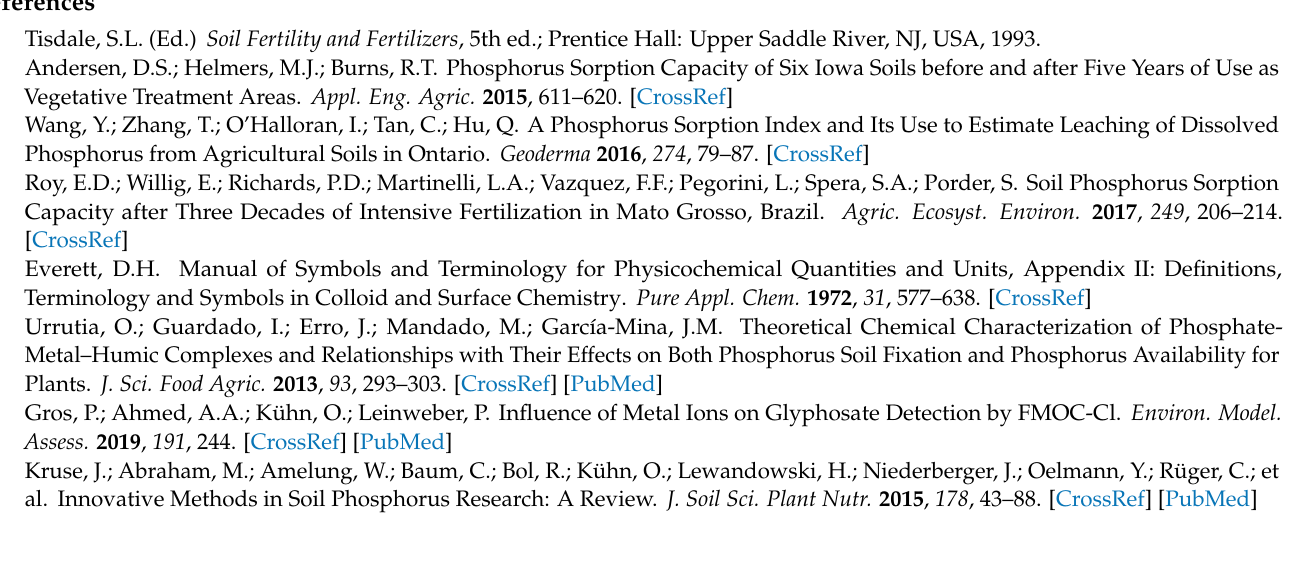
zeta potential, Figure S3: Initial motifs of IHP GP, Figure S4: Sum of covalent bond lengths in OP and GP B motifs, Figure S5: Seesaw movement of GP’s phosphate group, Figure S6: Multiple covalent bonds between surface irons atoms and water